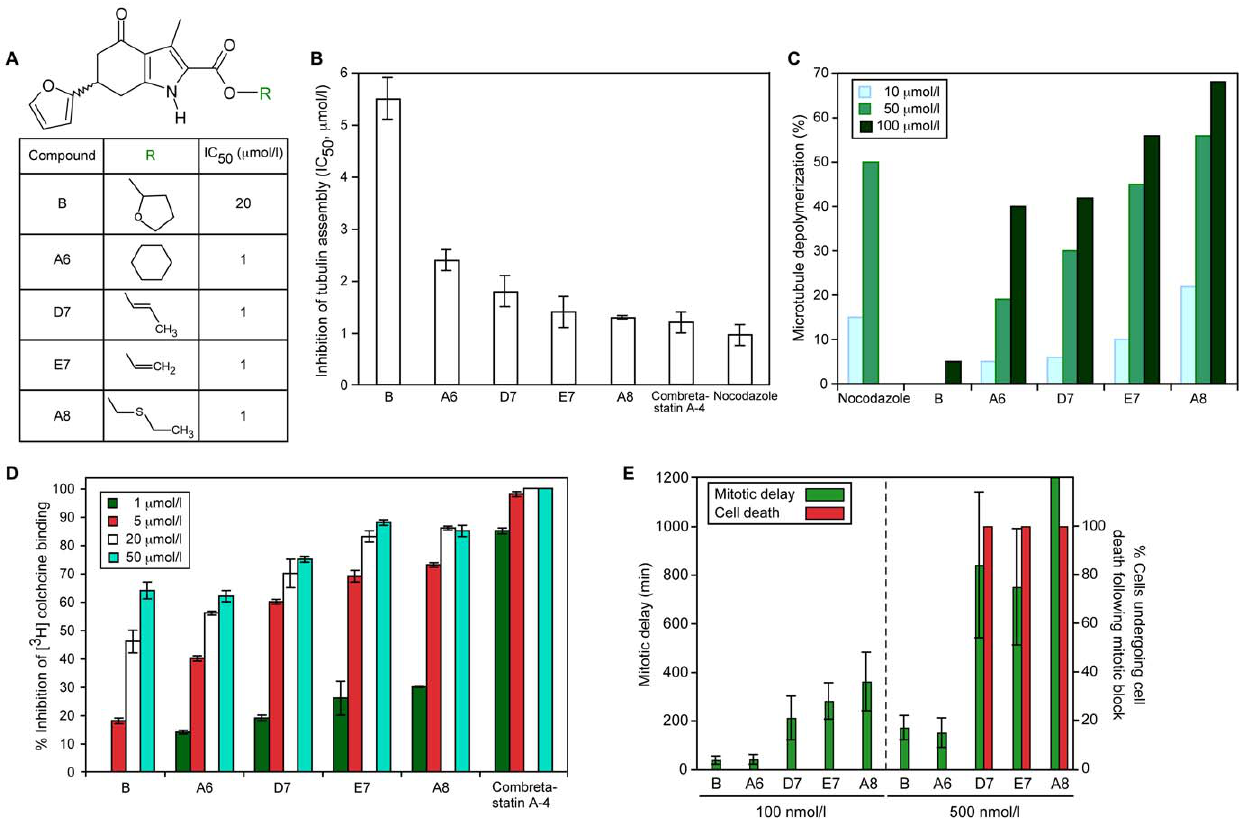
Figure 6. Furan-metoticas inhibit tubulin assembly and destabilize microtubules. Structures of furan-metoticas B, A6, D7, E7, and A8, and their IC 50 values measured in the Ndc80 488 -MT binding assay ( A ). Compounds A6, D7, E7 and A8 inhibited tubulin polymerization in vitro with an efficiency exceeding that of compound B; combretastatin A-4 and nocodazole acted as positive controls. The bars represent standard deviations ( B ). Compounds A6, D7, E7 and A8 efficiently depolymerized non-stabilized MTs in vitro ; nocodazole acted as a positive control ( C ). Compounds B, A6, D7, E7 and A8 competed with [ 3 H]colchicine for binding to tubulin; combretastatin A-4 acted as the positive control. The bars represent standard deviations ( D ). Furan-metoticas triggered a mitotic block and subsequent cell death with high efficiency in HeLa cells (cervical adenocarcinoma). The bars represent standard deviations ( E ).